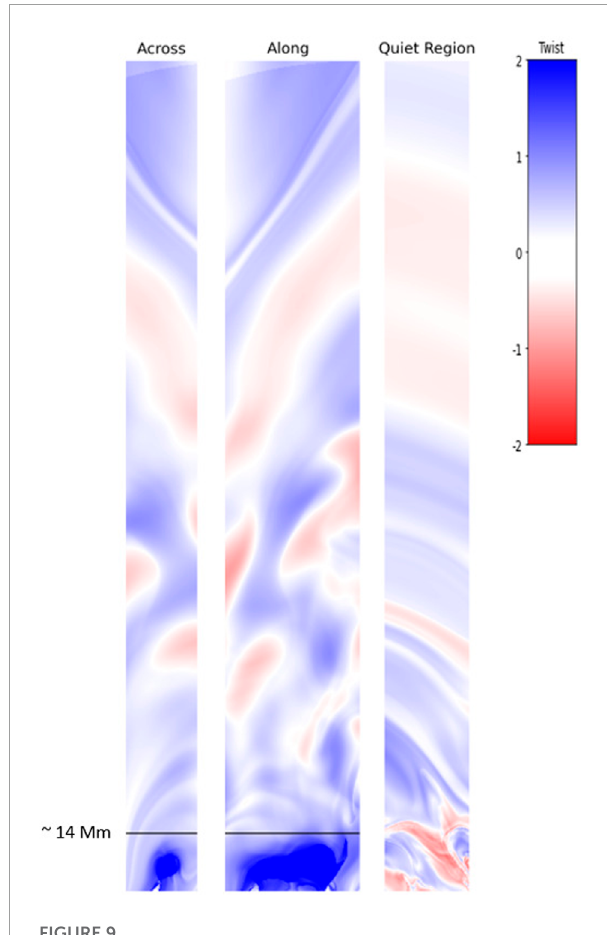
FIGURE 9 Vertical twist maps corresponding to the slices in Figure 8 , calculated from the 2012-03-07 00:00UT extrapolated magnetic field. The black line on the twist maps calculated across and along the PIL indicates the top of the MFR structure at an altitude around 14